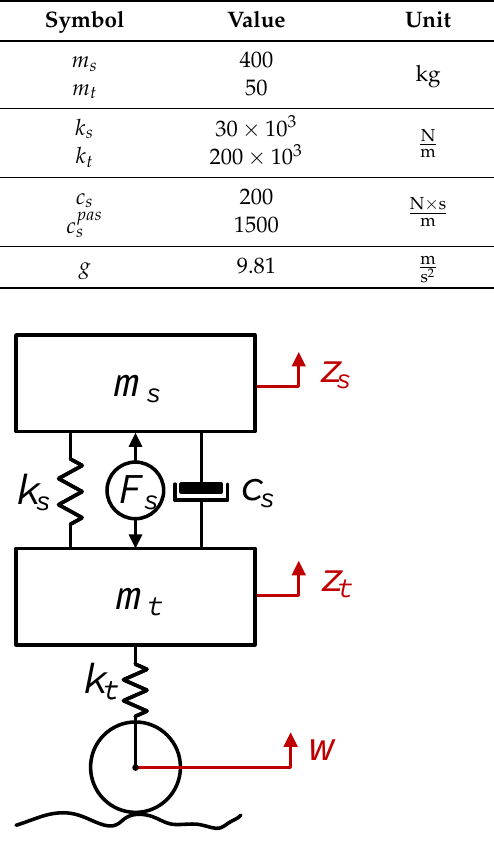
Table 1. Model parameters.